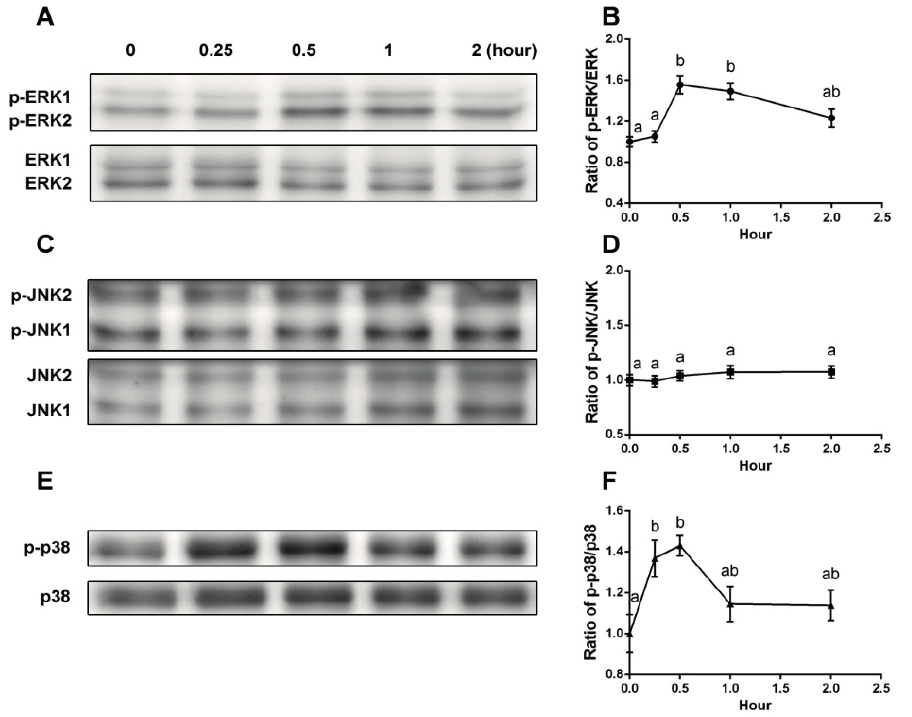
Figure 2. ( A , C , E ) Effects of YPEP on phosphorylations of ERK1/2, JNK1/2, and p38, respectively. ( B , D , F ) Densitometric results of ERK1/2, JNK1/2, and p38, respectively. Data are expressed as means ± SD of the three cultures. Values not sharing a common alphabet as superscripts are significantly different from each other at the level of p <